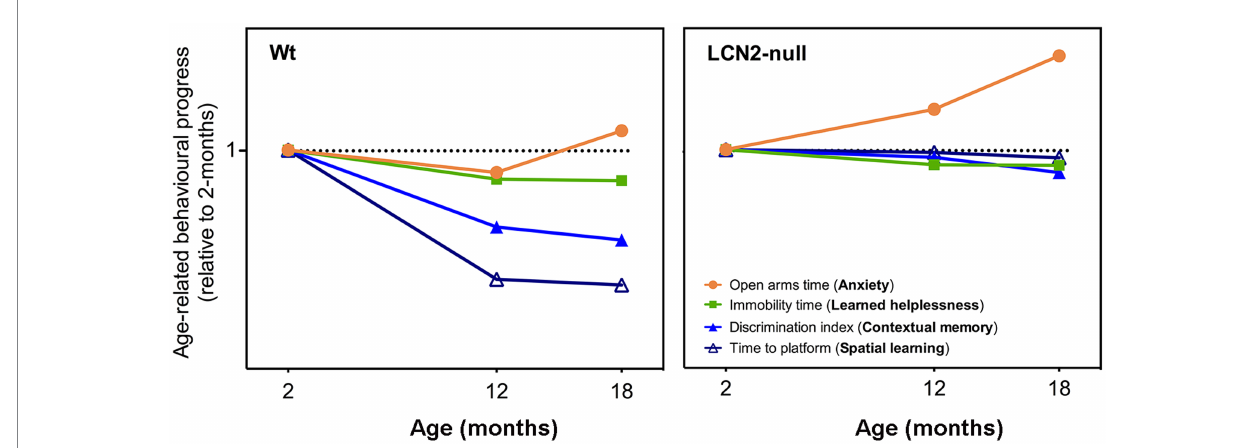
FIGURE 6 Schematic representation on the progression of the behavioral dimensions assessed throughout aging, in both Wt and lipocalin-2 (LCN2)-null mice. Comparison of behavioral performances of aged animals with younger ages revealed that aging, in Wt mice, slightly decreased their anxiety state at 18-months (as observed by the increased open arms time), but did not promote depressive-like behaviors (immobility time is decreased). Cognitive domains, both spatial learning and contextual discrimination, was significantly impaired with aging. On the other hand, aged LCN2-null mice sustained their impaired behavior observed already at 2-months of age, specifically in depressive-like behavior and cognitive domains, with the exception of anxiety that was significantly decreased (represented as the increased in the time spent in the open